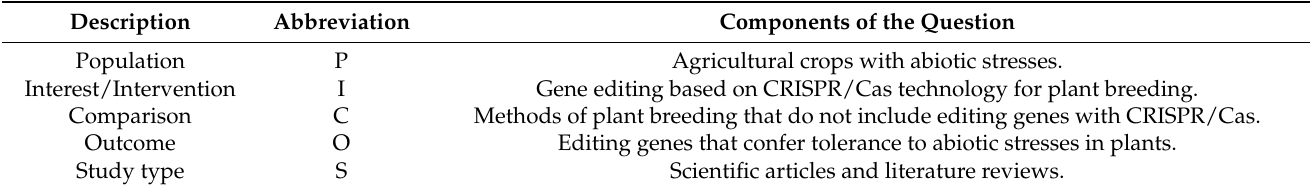
Table 3. Definition of the PICOS terms for the research “question” used in the systematic review of CRISPR/Cas technology being used to edit genes for tolerance to abiotic stresses in plants published in the last seven years.